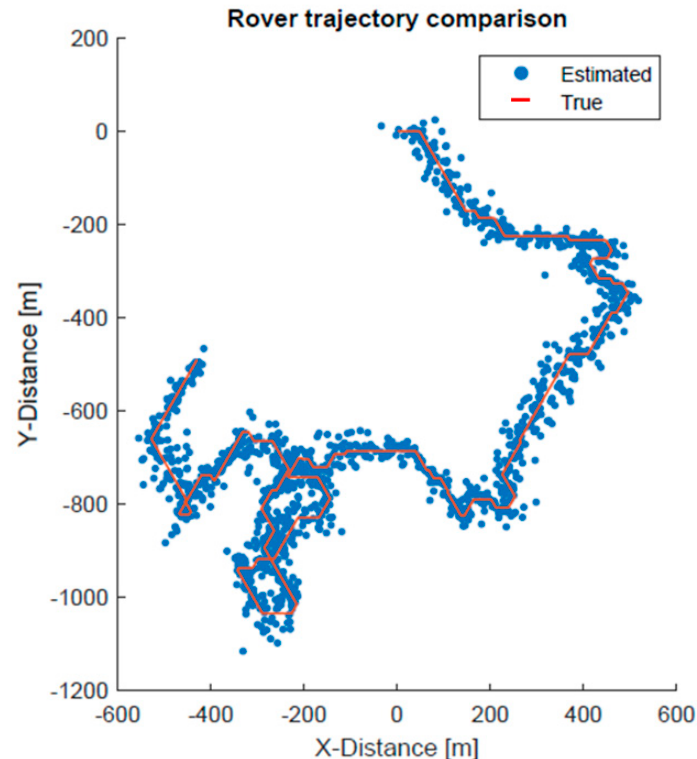
Figure 4. Example of simulation result: ( Red dots ) true rover trajectory; ( Blue dots ) rover positions estimated by MDPO (receiver observation errors ∆∇ω ( 𝟐 × 𝜎 ∆∇(cid:2985) ) = 0.4 m).